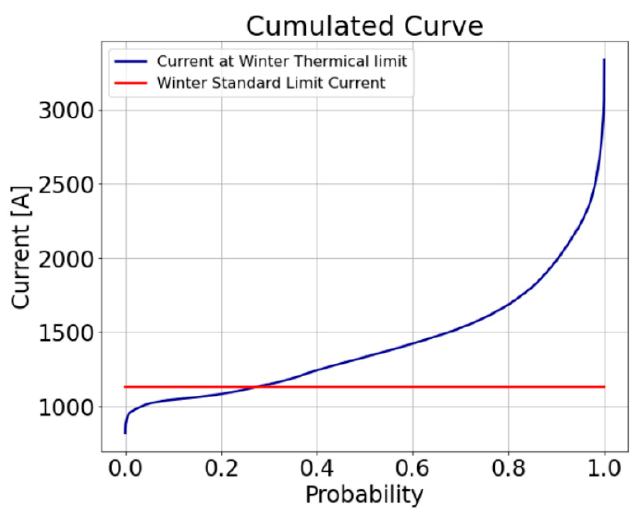
Figure 13. Cumulate current value for winter period of a generic HV Line.